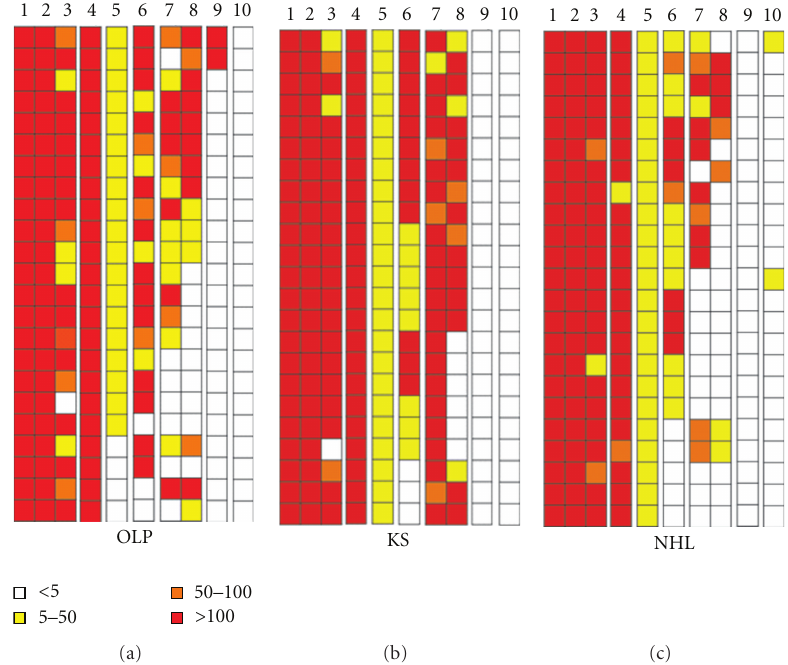
Figure 6: Heatmap analysis of antivirus antibody profiles in HIV patients with OLP, KS, and NHL. Antibody levels were evaluated against (1) gp41 of HIV, (2) RT of HIV, (3) p24 of HIV, (4) p23 of EBV, (5) VP1 of MCV, (6) core of HBV, (7) K8.1 of KSHV, (8) v-cyclin of KSHV, (9) NS3 of HCV, and (10) E7 of HPV. As shown in the key, the color code reflects the relative titers in standard deviations above the mean plus five SD of the control subjects or bu ff er blanks. Individual antibody profiles were then manually clustered based on the presence or absence of particular antibodies. Each row represents an individual